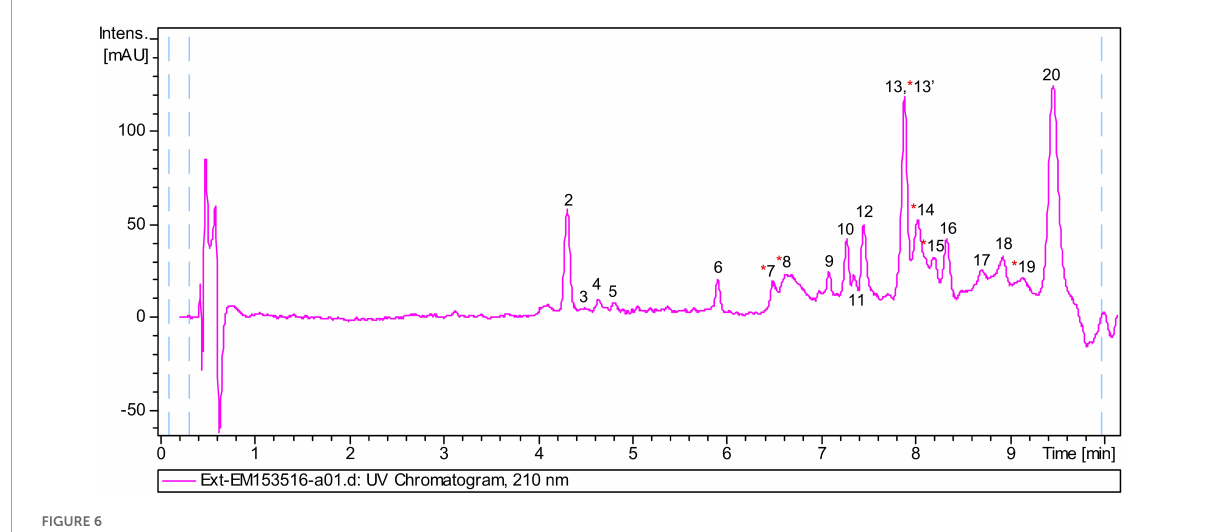
FIGURE6 Liquid chromatography and high-resolution tandem mass spectrometry analysis of the lipidic extract from Leeuwenhoekiella parthenopeia Mr9 T showing 20 peaks in the chromatogram. Red asterisk, known components.